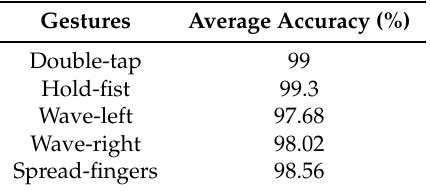
Table 5. Classification accuracy of different gesture